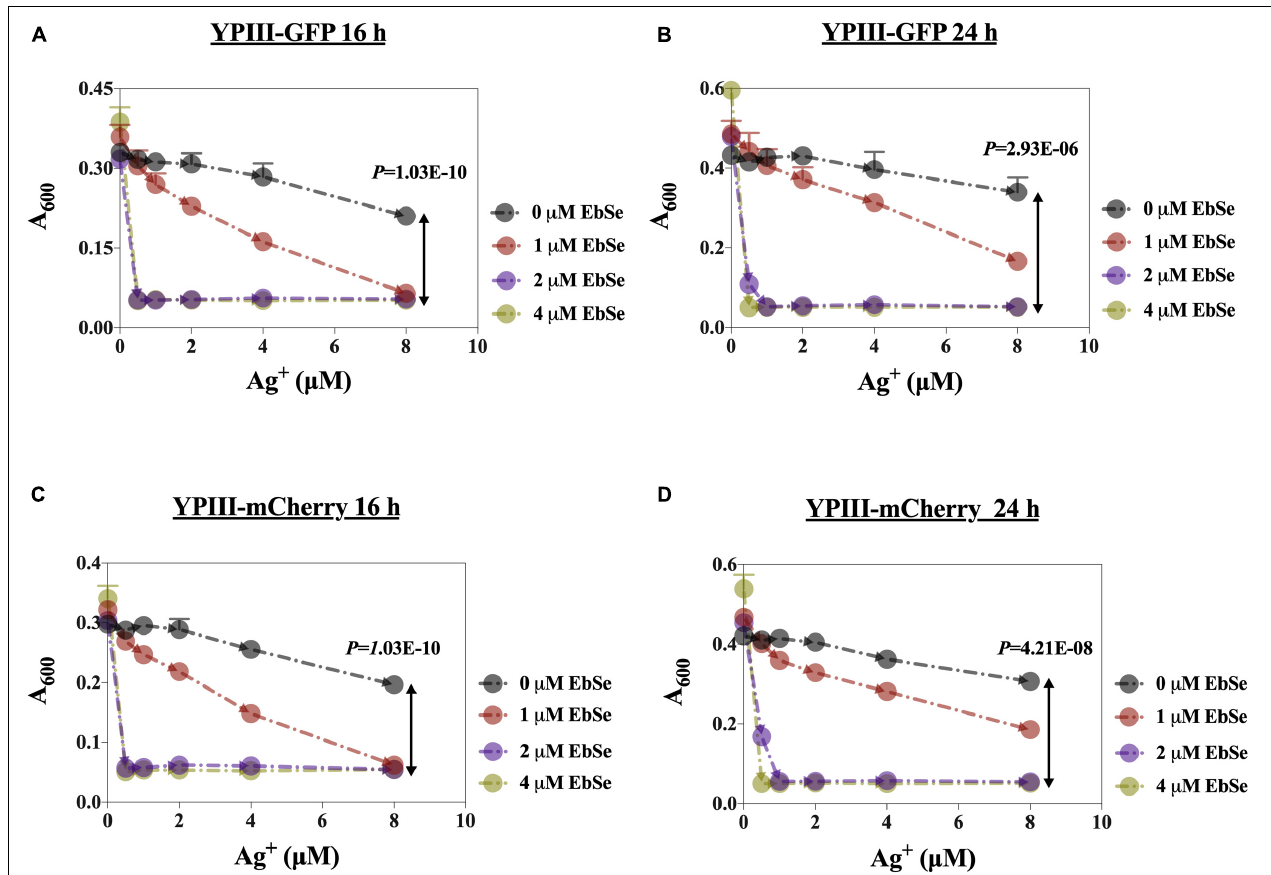
FIGURE 1 | EbSe-Ag + shows synergistic antibacterial activity against YpIII. YpIII-GFP and YpIII-mCherry were cultured to A 600 of 0.4, diluted 1:1,000 times, and treated with EbSe-Ag + . (A,C) At 16 h; (B,D) at 24 h; (A,B) YpIII-GFP; (C,D) YpIII-mCherry.